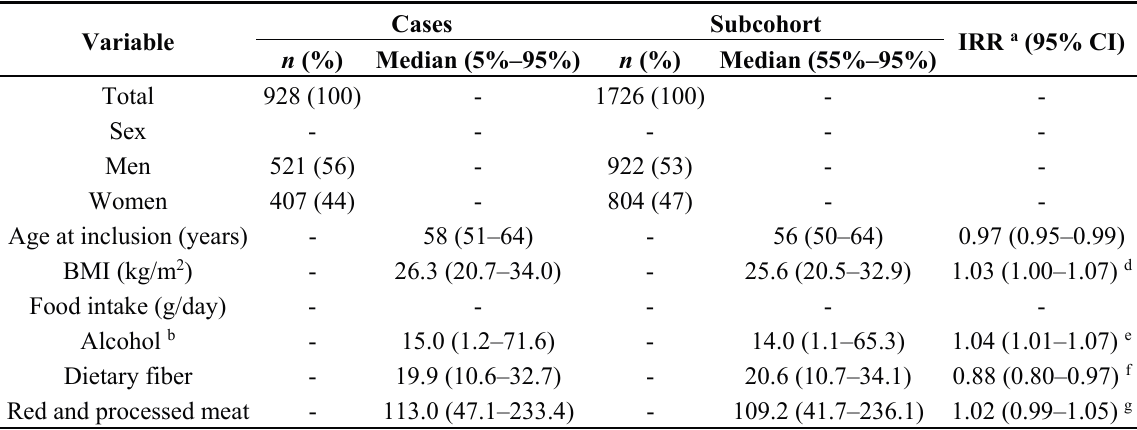
Table 1. Baseline characteristics of the study participants by selected demographic and established colorectal cancer risk